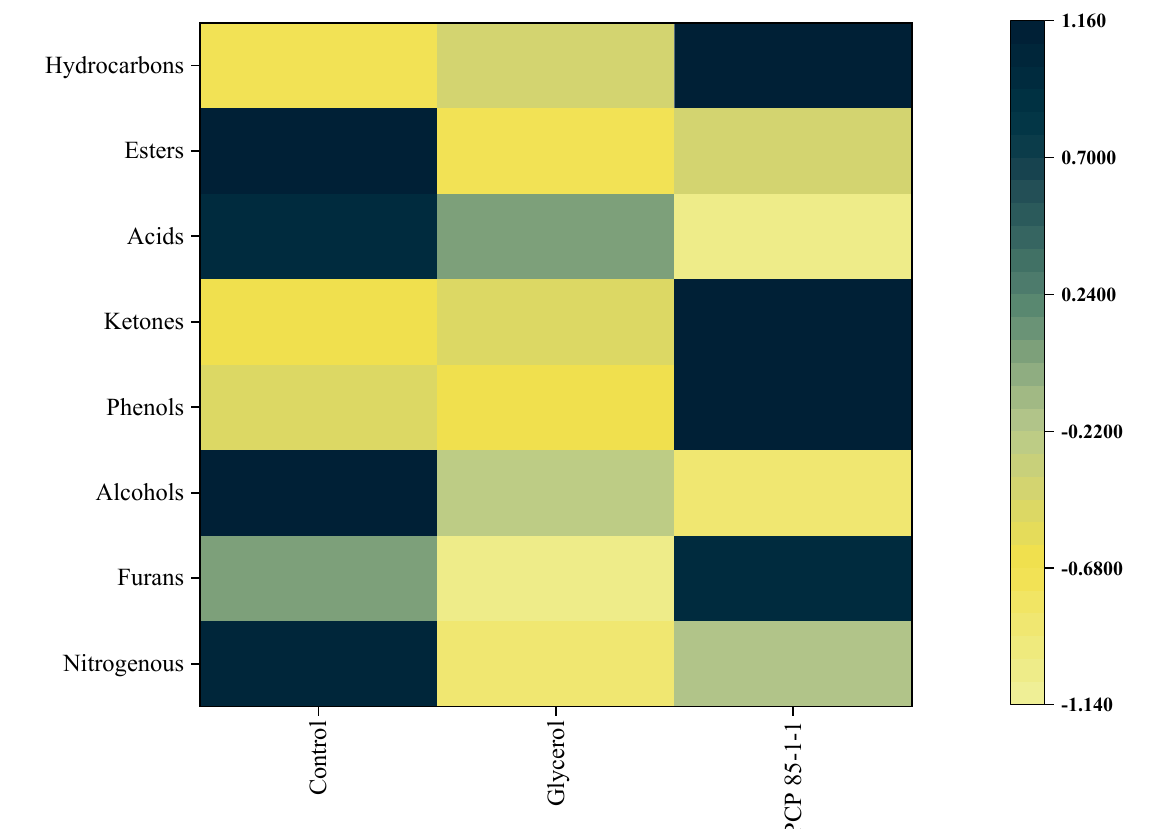
Figure 7. Hot map of the kinds of volatile compounds in the extract of tobacco shreds after smoking.